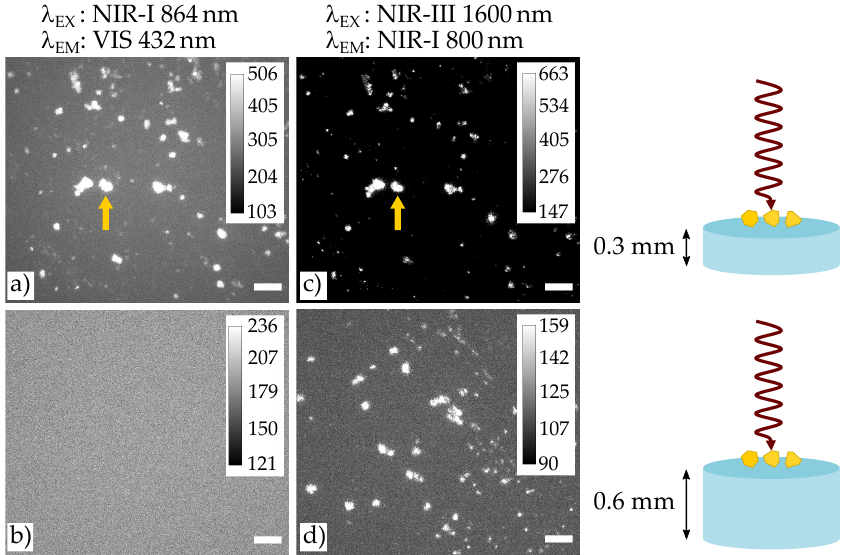
Figure 4. Study of the HNP emission in presence of a phantom tissue thickness of 0.3mm ( a , c ) and 0.6mm ( b , d ) for two different excitation wavelengths belonging, respectively, to NIR-I ( a , b ) and NIR-III ( c , d ). Scale bar is 50 µ m for all